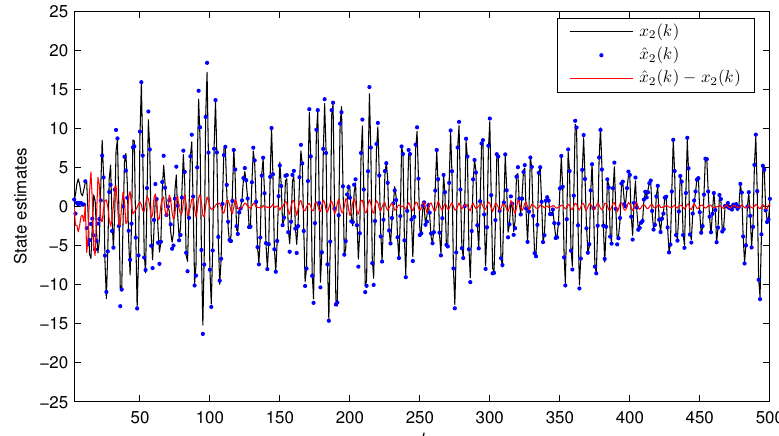
Figure 4. The state x 2 ( k ) and the estimated state ˆ x 2 ( k ) versus k for Example 1 ( δ = 0.25).